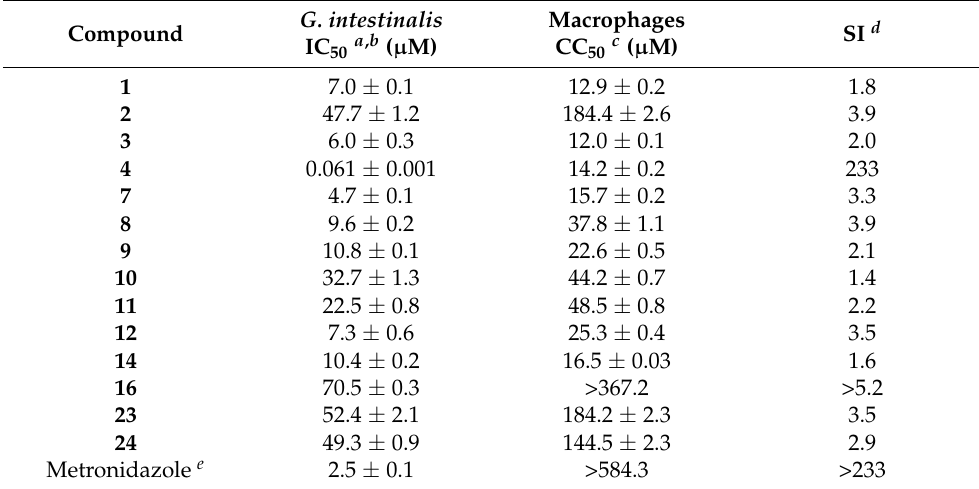
Table 4. Activity against trophozoite stage of Giardia intestinalis and cytotoxicity against the murine macrophage J774 cell line of flavonoids 1 – 29 isolated from Piper